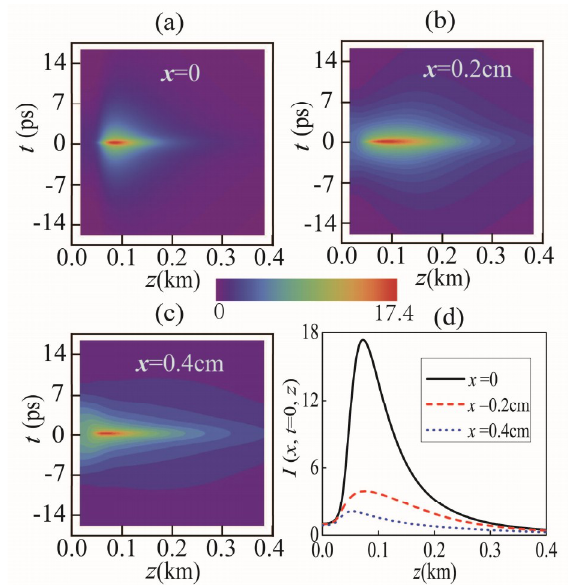
Figure 4. Evolution of normalized spatial-temporal intensity I ( x , t , z ) of PCP beams with Gaussian weight function with di ff erent values of x : ( a ) x = 0, ( b ) x = 0.2 cm and ( c ) x = 0.4 cm in the t - z plane. ( d ) Normalized spatial-temporal intensity versus propagation distance z with t = 0.